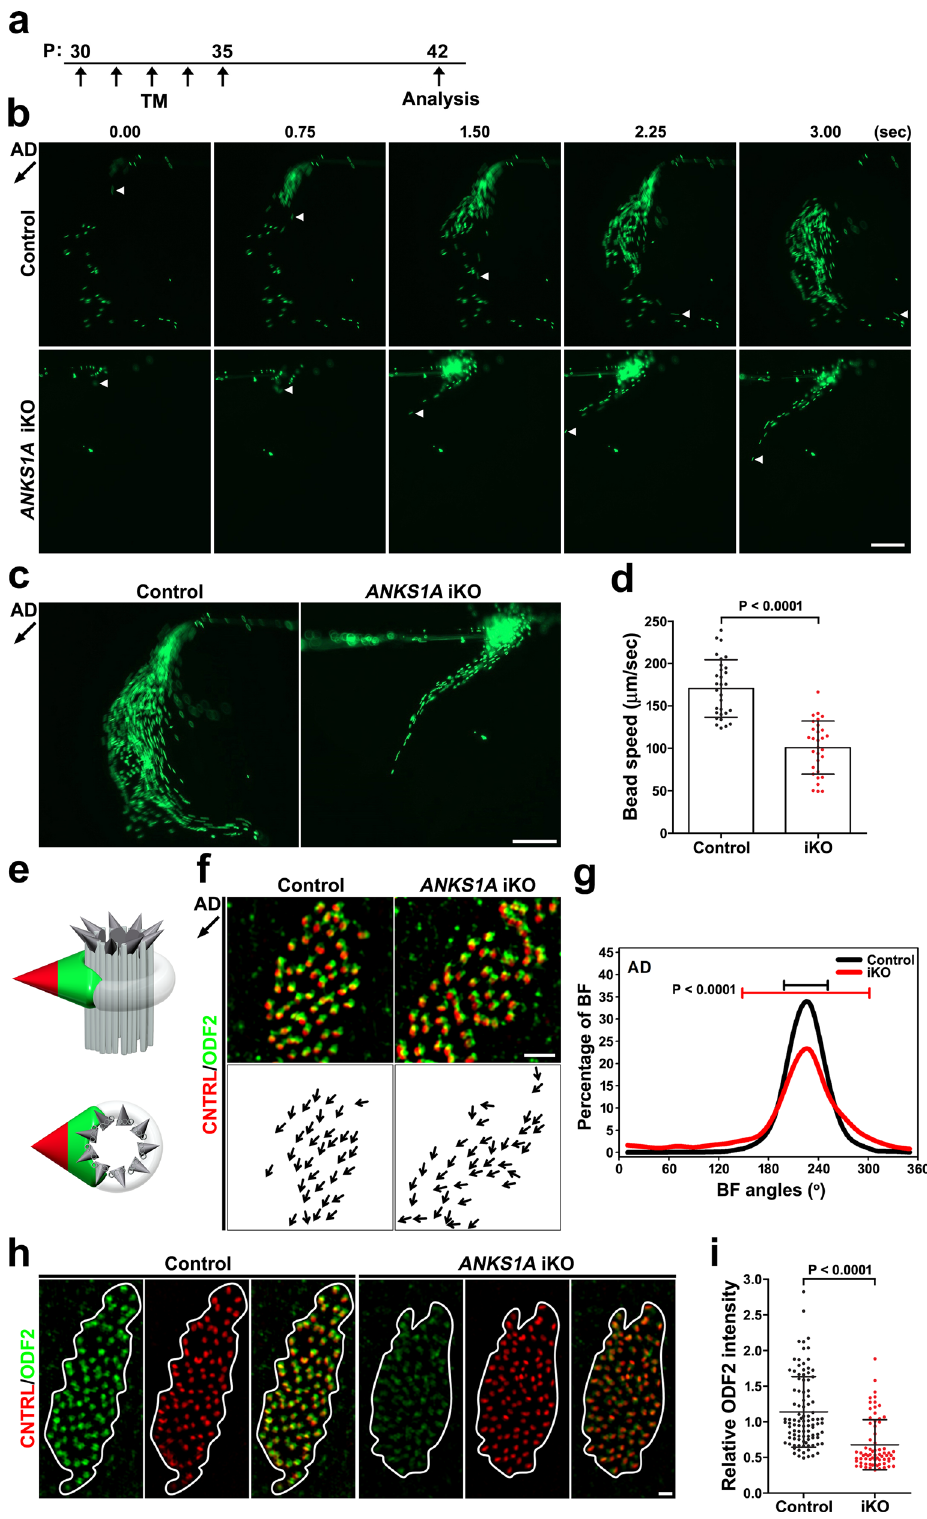
Fig. 5 Inducible ANKS1A ablation results in a rotational polarity defect, affecting the SDAs. a Control and iKO mice were generated via fi ve separate daily TM injections from P30 to P35. b The mice were sacri fi ced at P42 for live LW preparation, and the experiments were performed essentially as described in Fig. 3. c Thirty- fi ve consecutive frames of Supplementary Movie 3 were merged into a single picture. Scale bar for b , c , 200 μ m. d Data presented in b were used to calculate an average bead speed based on three independent experiments. Data represent mean ± SD. e Double staining for both ODF2 (green) and CNTRL (red) permitted the visualization of rotational polarity. f , g Experiments were performed as described in Fig. 4b, c. h , i Experiments were performed as described in Fig. 2e, f. Scale bar for f , h , 1 μ m. Control set, n = 99 cells; ANKS1A iKO, n = 71 cells.